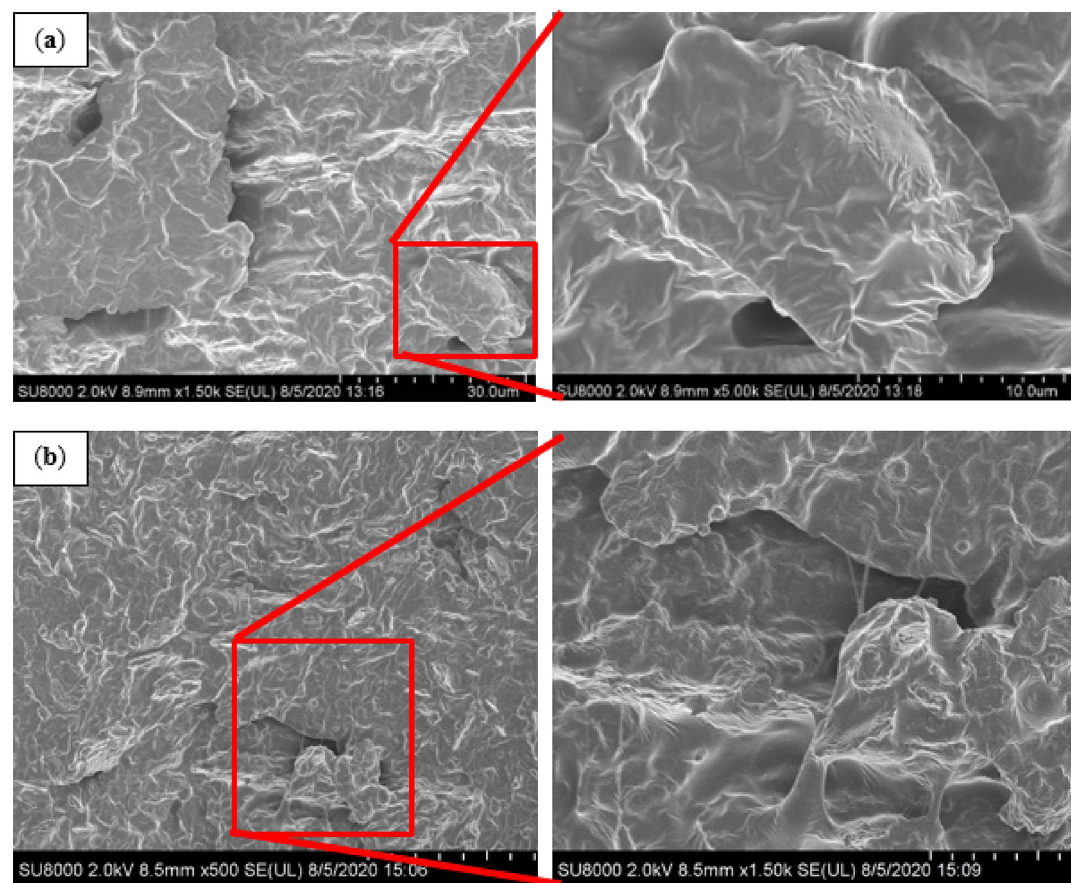
Figure 7. FESEM images of MRE containing embedded ( a ) non-corroded plate-like CIPs and ( b ) corroded plate-like CIPs (treated with 1.0 vol.%